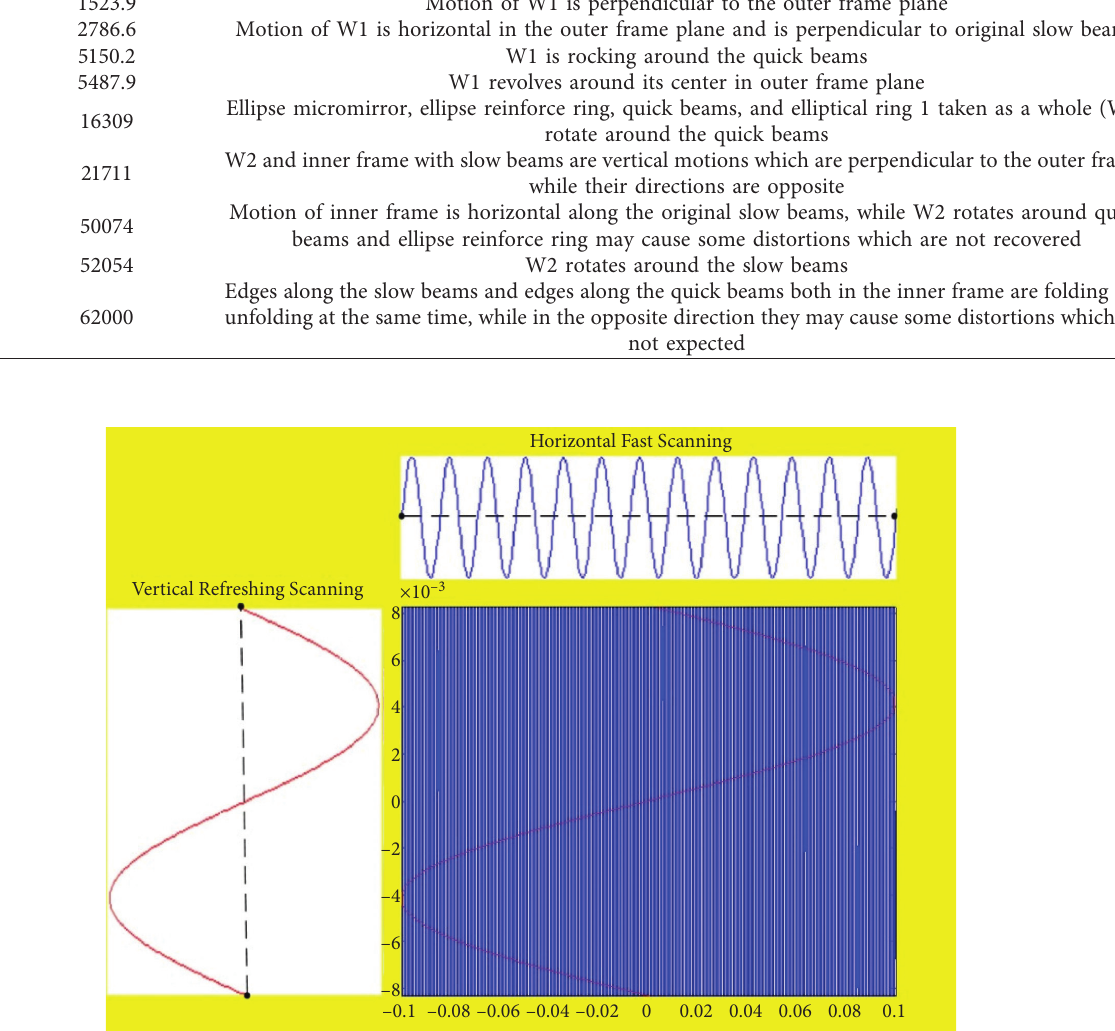
Figure 3: Principle of raster scanning.